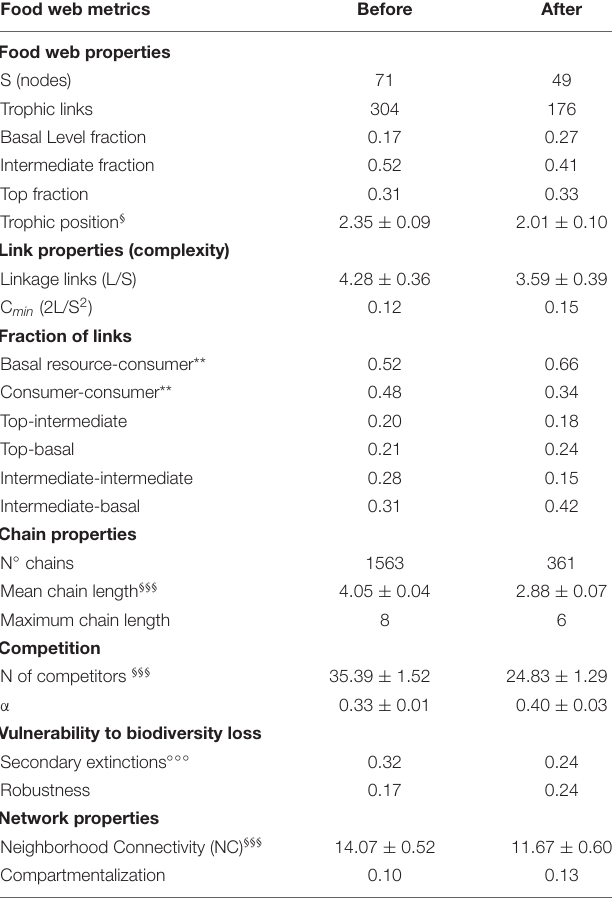
TABLE 3 | Food web metrics BEFORE and AFTER in Terra Nova Bay, Ross Sea. Food web